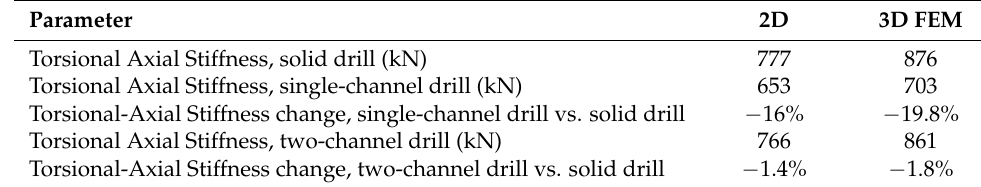
Figure 8. Axial deformation (warping) of the top surface as calculated by the 3D FEM ( a ) solid drill (max: 1.43 μ m), ( b ) drill with a central channel (max: 1.82 μ m), ( c ) two-channel drill (max: 1.46 μ m). Table 3. Torsional-axial stiffness calculated using the 2D method and the 3D FEM.